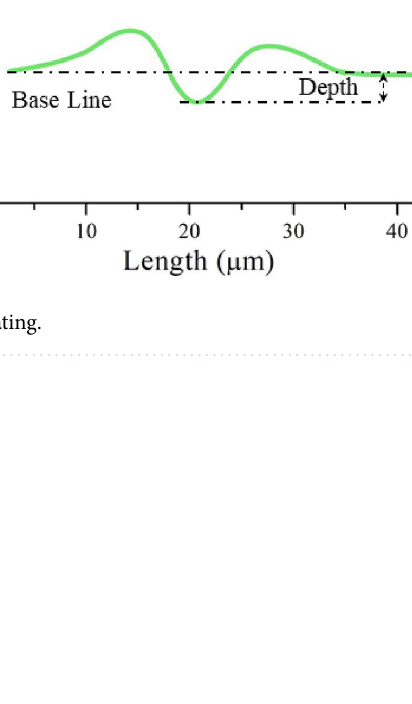
Table 1. Composition of binder, powder, and solvent in the heterogeneous mixture.